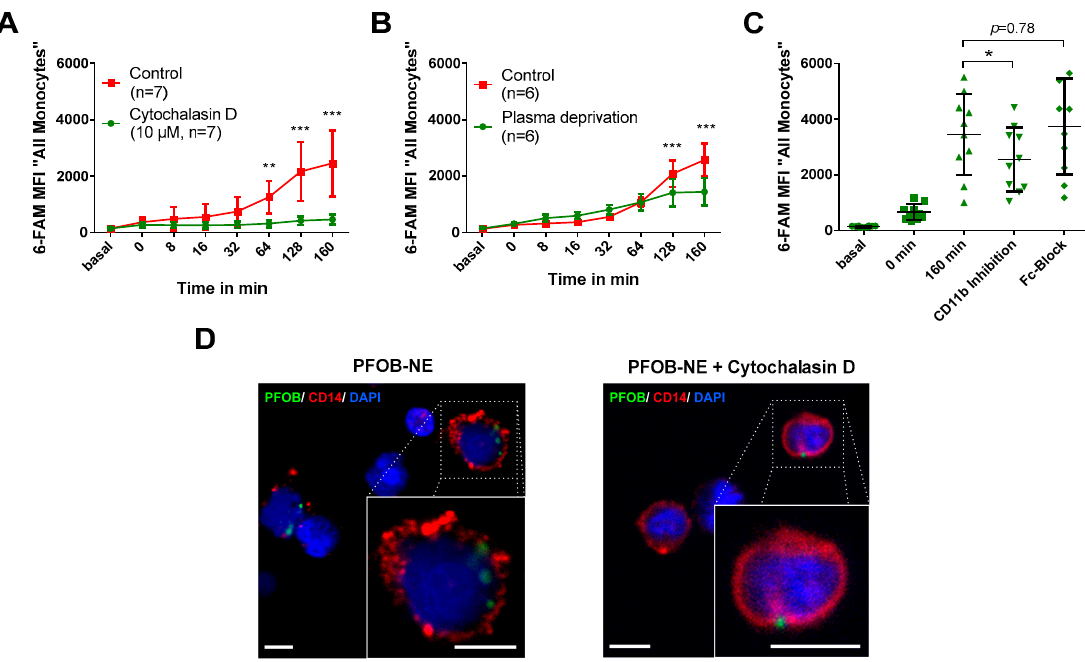
Figure 3. PFOB-NE is internalized by active phagocytosis. Whole blood samples were exposed to PFOB-NE ( A ) with or w / o use of Cytochalasin D ( n = 7), ( B ) with or w / o plasma deprivation ( n = 6) or ( C ) with or w / o CD11b- or Fc-inhibiton ( n = 10) and analysed for cell-associated fluorescence by flow cytometry. ( D ) Confocal analysis of PFOB-NE internalization in CD14 + monocytes (red). Whole blood samples were pre-incubated with or w / o Cytochalasin D and subsequently exposed to PFOB-NE (green) for 128 min. Nuclei were counterstained with DAPI (blue). Small boxes indicate area magnified in large boxes. All scale bars, 5 µ m.* p < 0.05, ** p < 0.01, *** p <